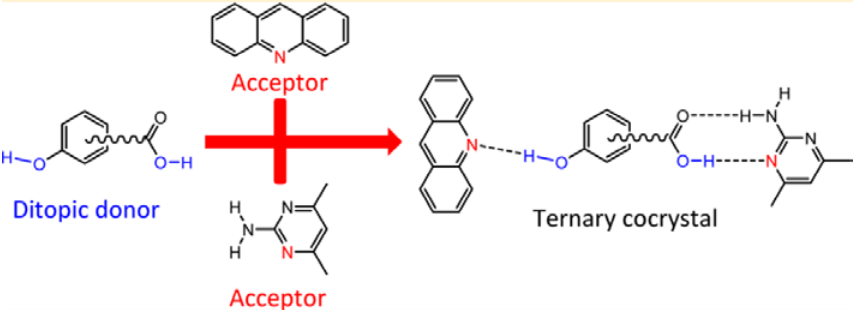
Figure 25. Schematic representation of ditopic hydrogen bond donors and acceptors combination strategy proposed by Adsmond et al. (2016) in formation of acridine-3-hydroxybenzoic acid-2-amino-4,6-dimethylpyridine (1:1:1) cocrystal [Reprinted from [264] with permission. Copyright 2016 American Chemical Society].